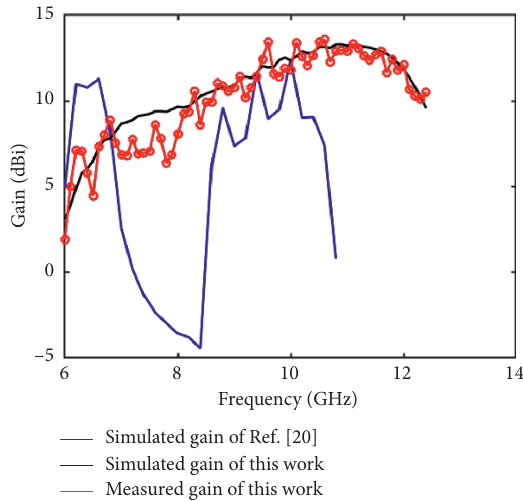
Figure 21: The gain of the antenna of [20] and the proposed periodic MLWA antenna.